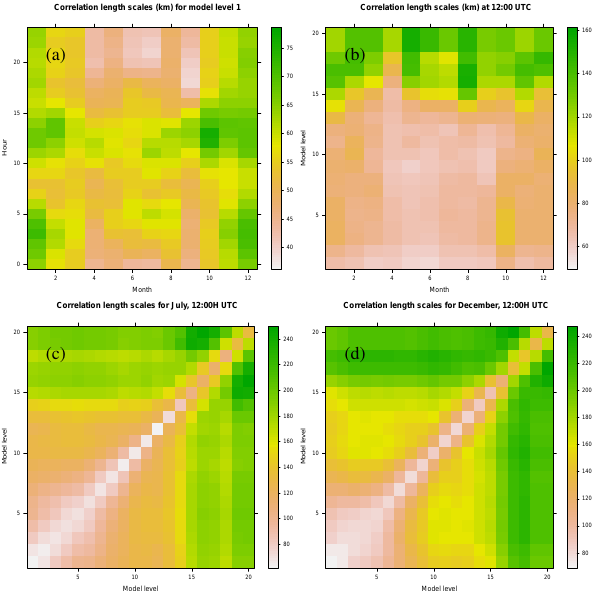
Fig. 5. The estimated correlation length scale, L l,l 0 ; m,h , as a function of month, hour of the day and vertical level. (a) shows diurnal and seasonal variation in the lowest model level, while (b) presents seasonal variation in L l,l ; m,h (i.e. length scales valid for two points on the same vertical level) at different vertical layers for 12:00 UTC only. The relationship between length scale and pairs of vertical lay- ers in July and December are shown in (c) and (d) . Note that dif- ferent colour scales were used for each panel to highlight variation within each graph.